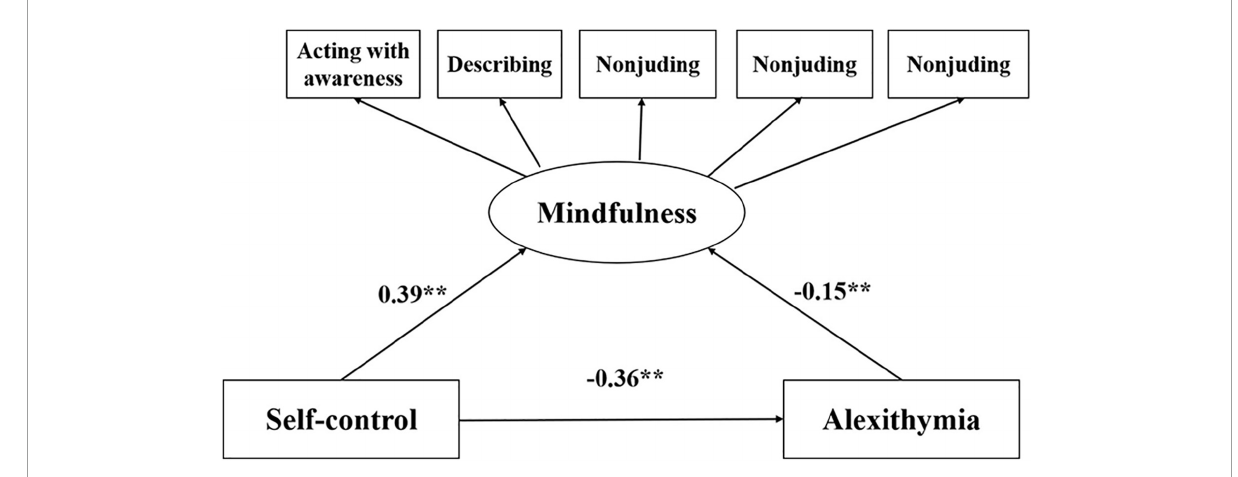
FIGURE4 Structural equation modeling of the mediating role of mindfulness in the relationship between self-control and